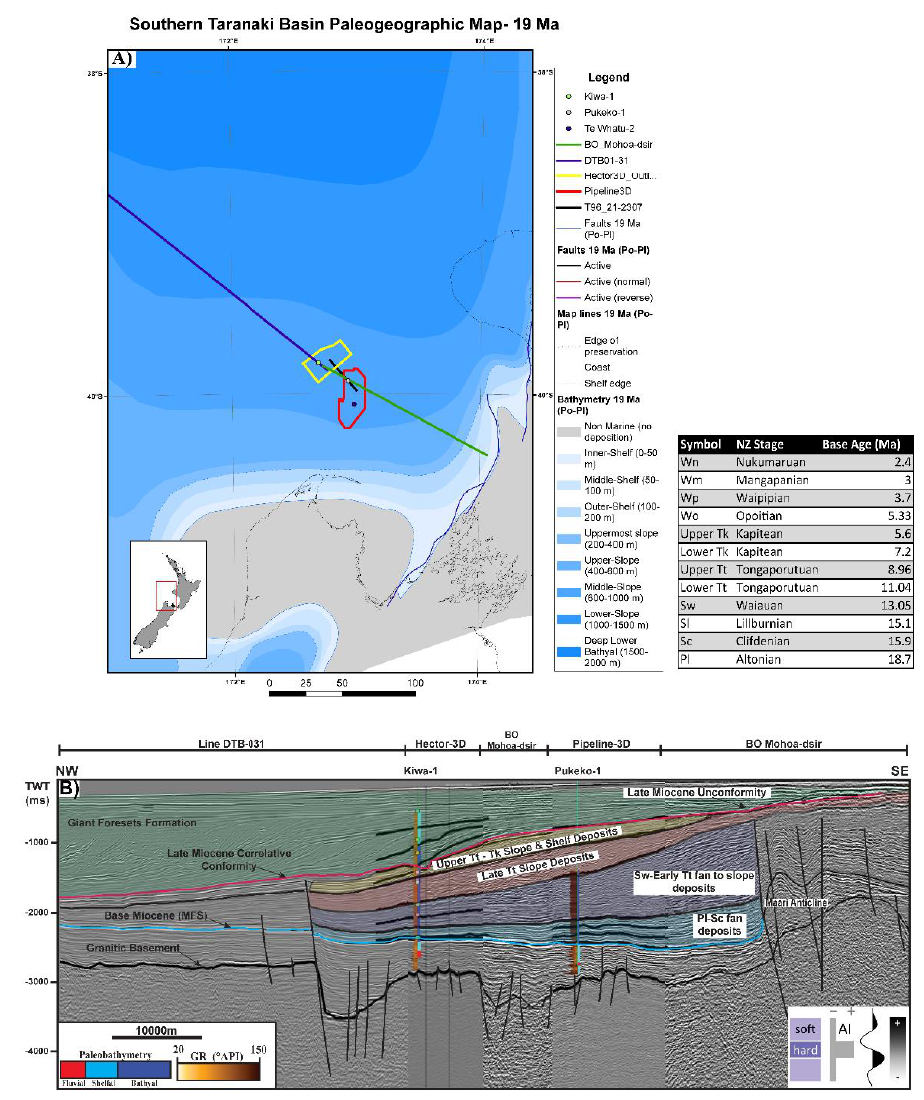
Figure 1. ( A ): A 19 Ma Paleogeographic map of the southern Taranaki Basin with the seismic surveys and well locations used in this study overlain. Modified after Arnot and Bland (2016) [12]. ( B ): regional composite 2D seismic section through the southern Taranaki Basin with depositional environment interpretations overlain. A summary of the Taranaki Basin Timescale abbreviations is provided in the